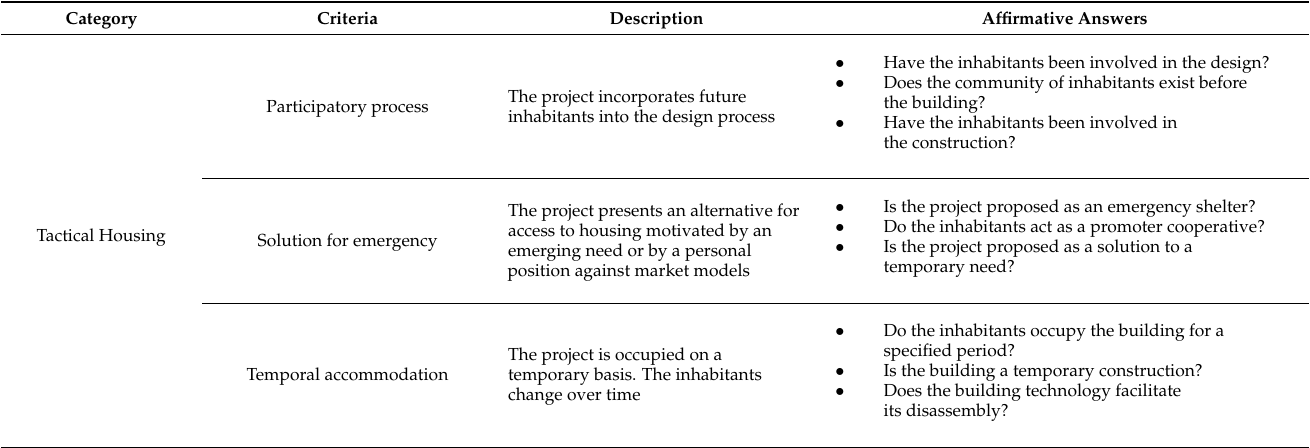
Table 1. Qualitative questionnaire for diffuse dwelling projects